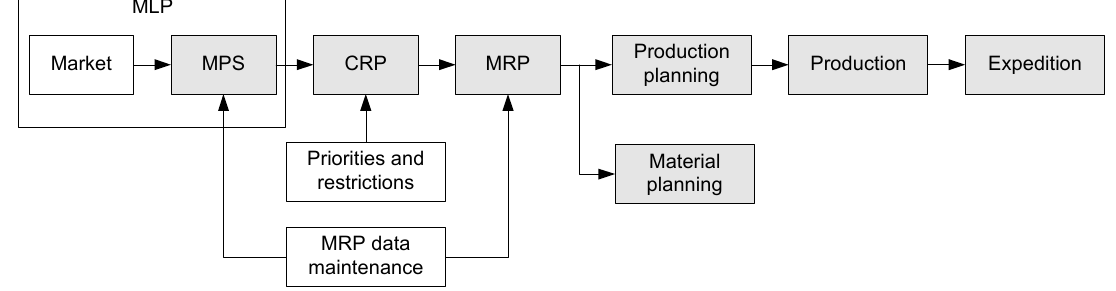
Figure 3. Formalized medium-term planning scheme.